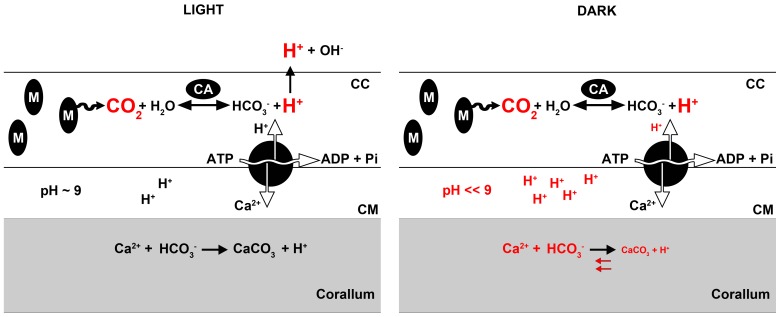
Conceptual model of dark calcification impairment by heterotrophy.Feeding increases metabolic rates, CO2 production, and as a result proton production in calicoblastic cells. In light, these protons are titrated by photosynthetically generated hydroxide ions in the coelenteron. In darkness, protons accumulate in the calicoblastic ectoderm, increasing the proton gradient between the calicoblastic ectoderm and the calcifying medium (CM). This causes a temporary decrease of the CM pH and aragonite saturation state, shifting the calcification reaction to the left. CC: calicoblastic cell. CM: calcifying medium. M: mitochondrion. CA: carbonic anhydrase. Model based on [10] and [17].